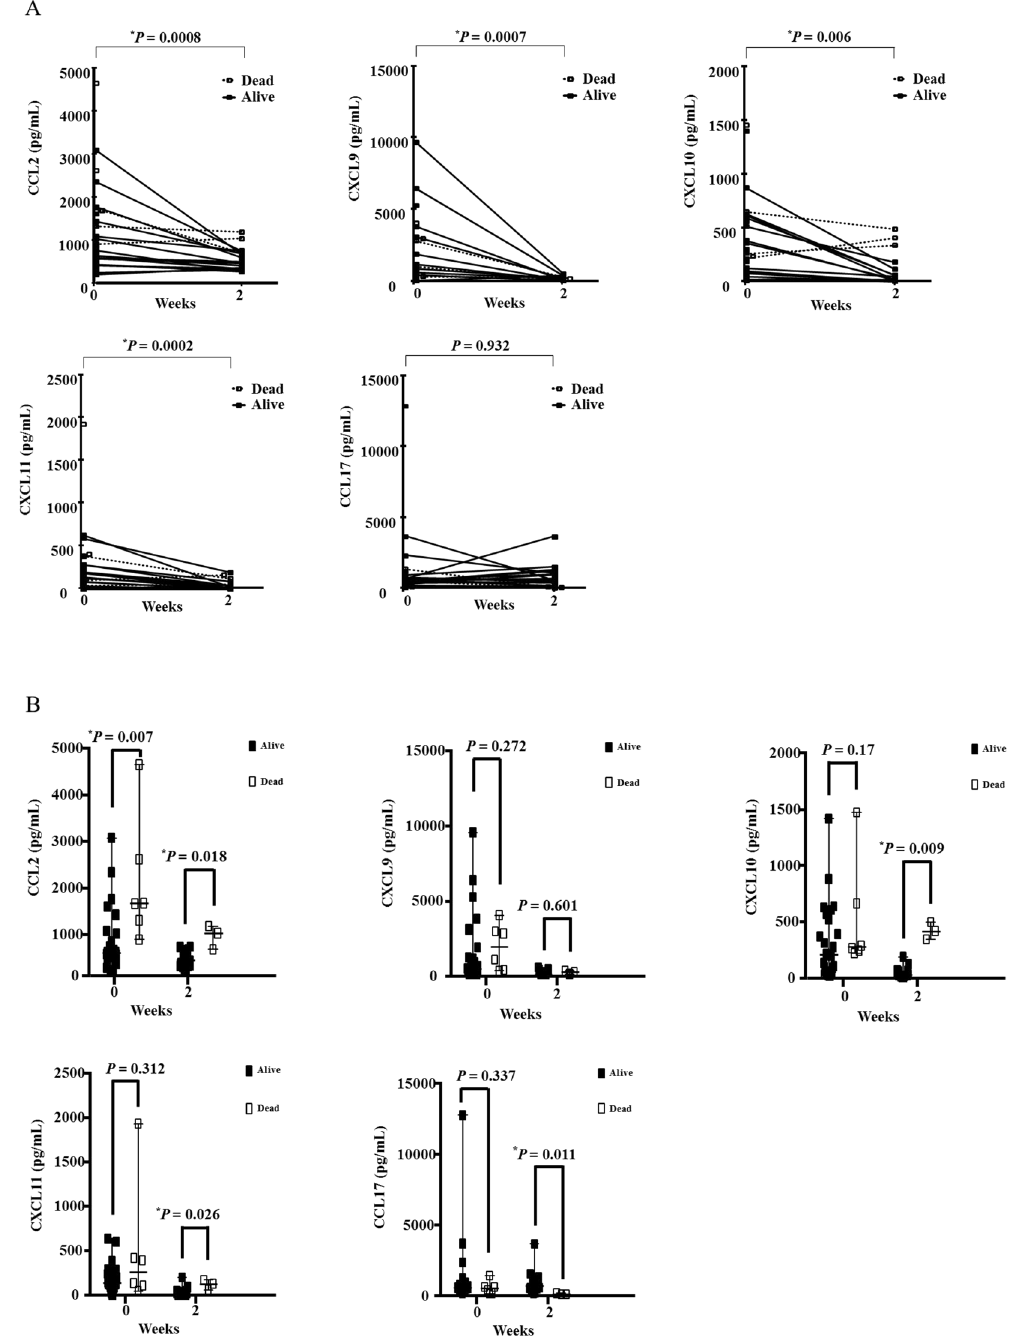
Figure 2. Changes in and Comparison of serum chemokine levels of DM-IP initially and at 2 weeks after treatment between survivors and non-survivors. ( A ) The time series of each chemokine; ( B ) The comparison of serum chemokine levels initially and at 2 weeks after treatment between the survival group and the death group; CCL: C-C motif chemokine ligand; CXCL: C-X-C motif chemokine ligand; closed square: alive patients (Alive); open square: patients dead due to interstitial pneumonia (Dead). The P value was estimated by Wilcoxon’s rank sum test. * P <